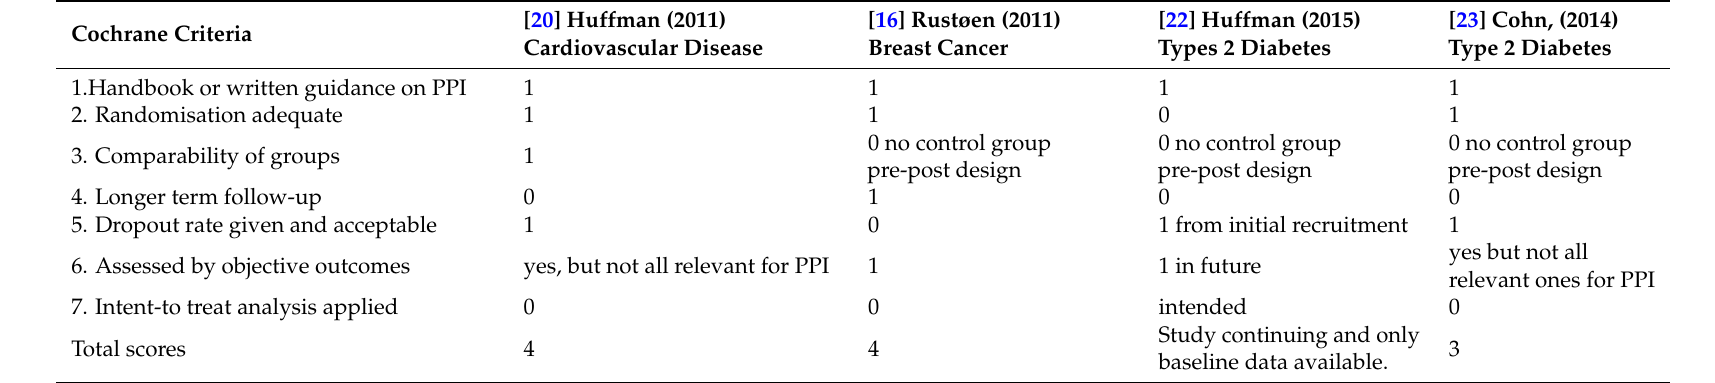
Table 2. Application of Cochrane Criteria to